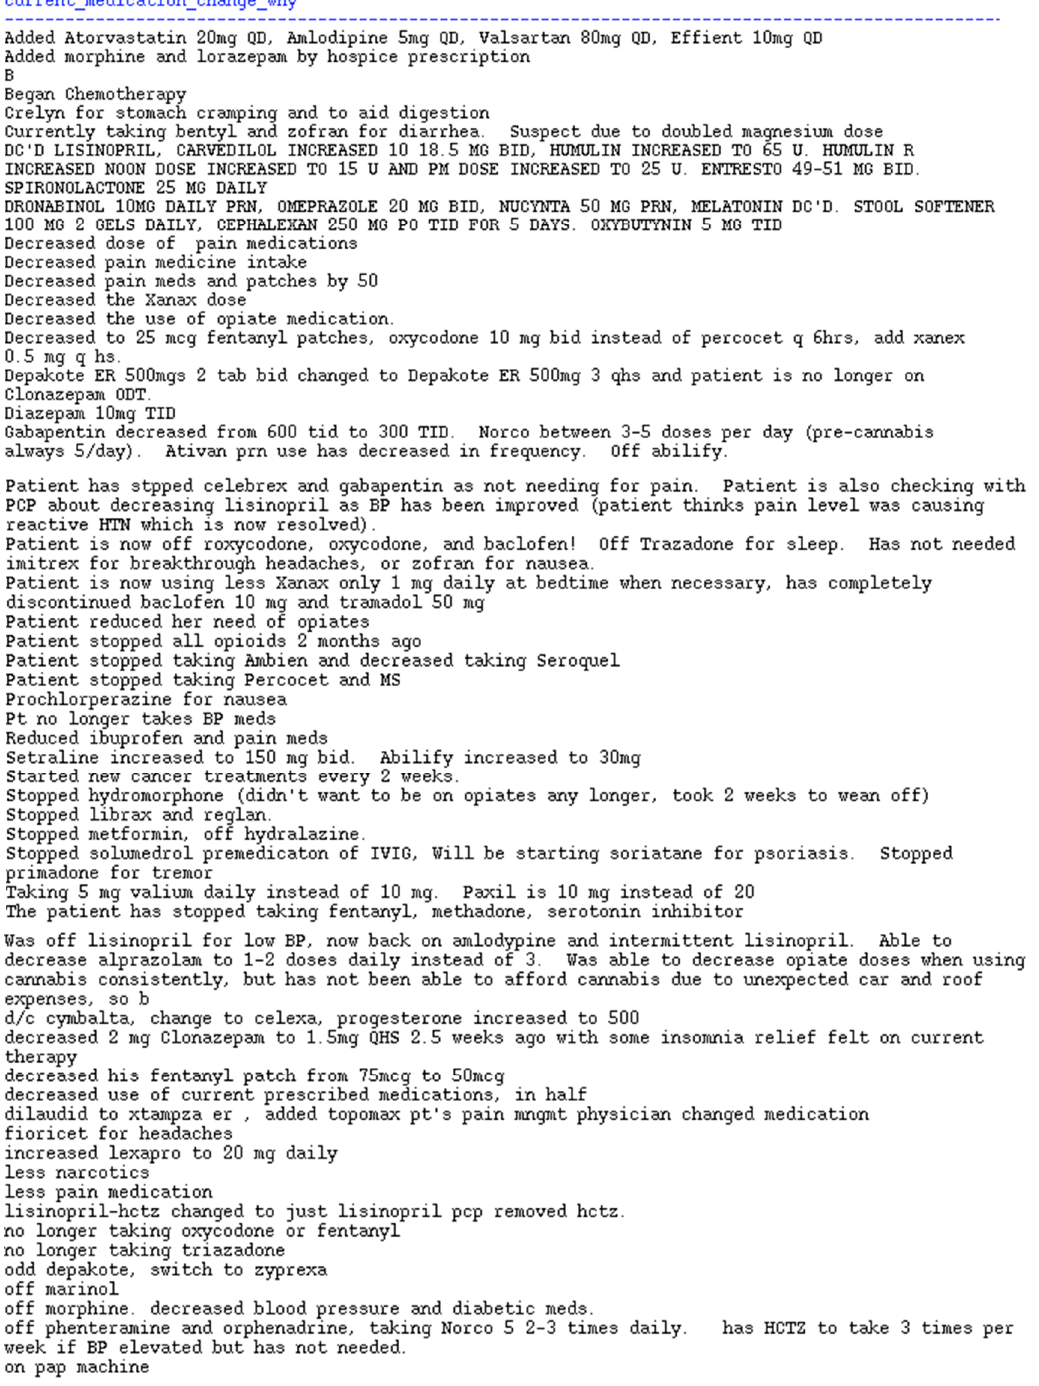
Figure A1. Reasons for Change in Current Medication Noted During Follow-Up Visits; N = 85 entries.